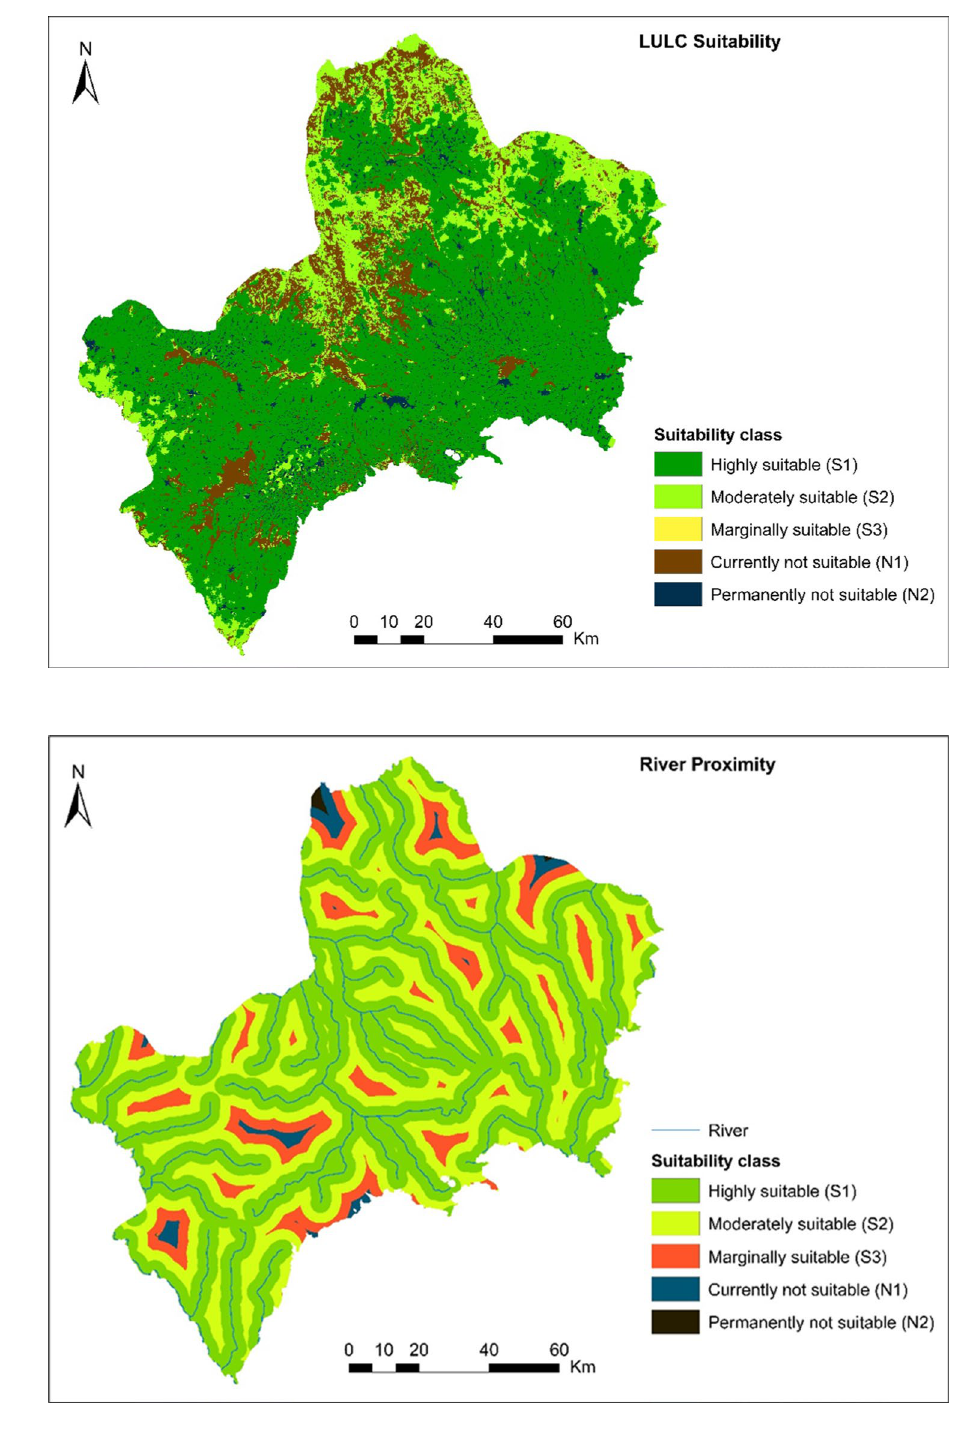
Fig. 8 Land use land cover suit- ability map